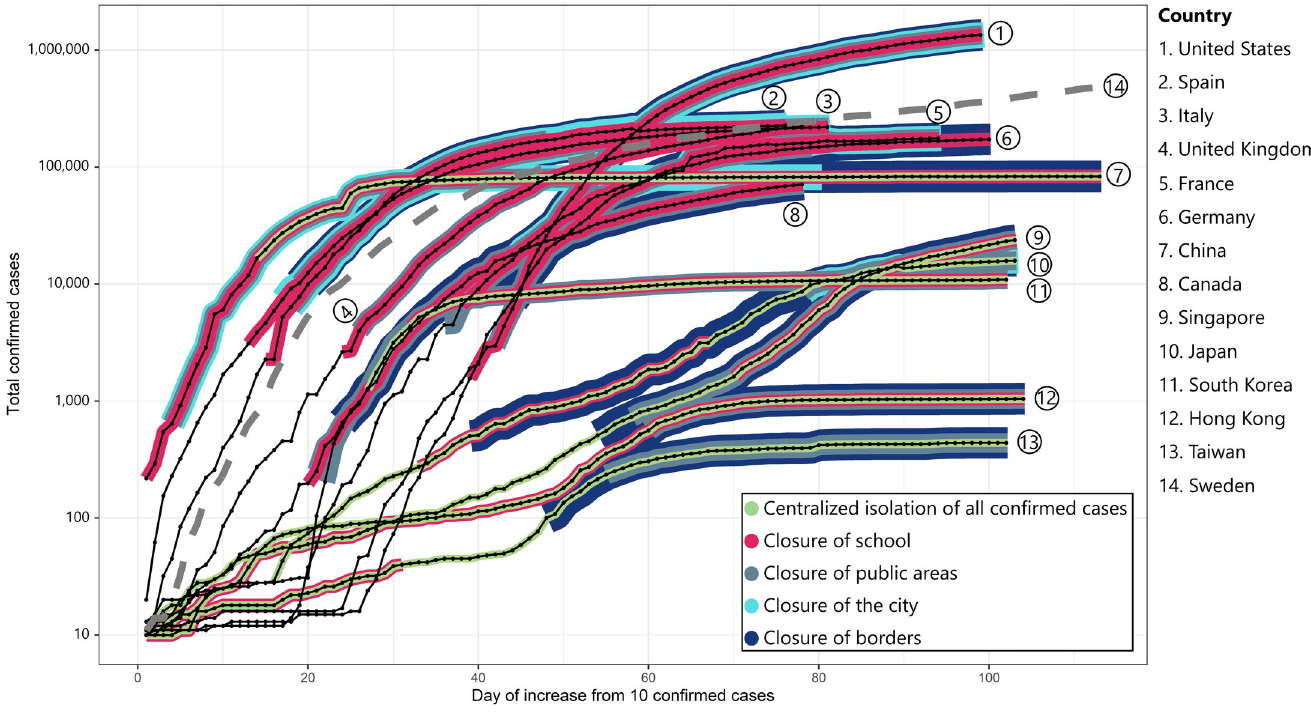
Fig 1. Analysis of anti-epidemic solutions according to the number of COVID-19 cases trajectories.